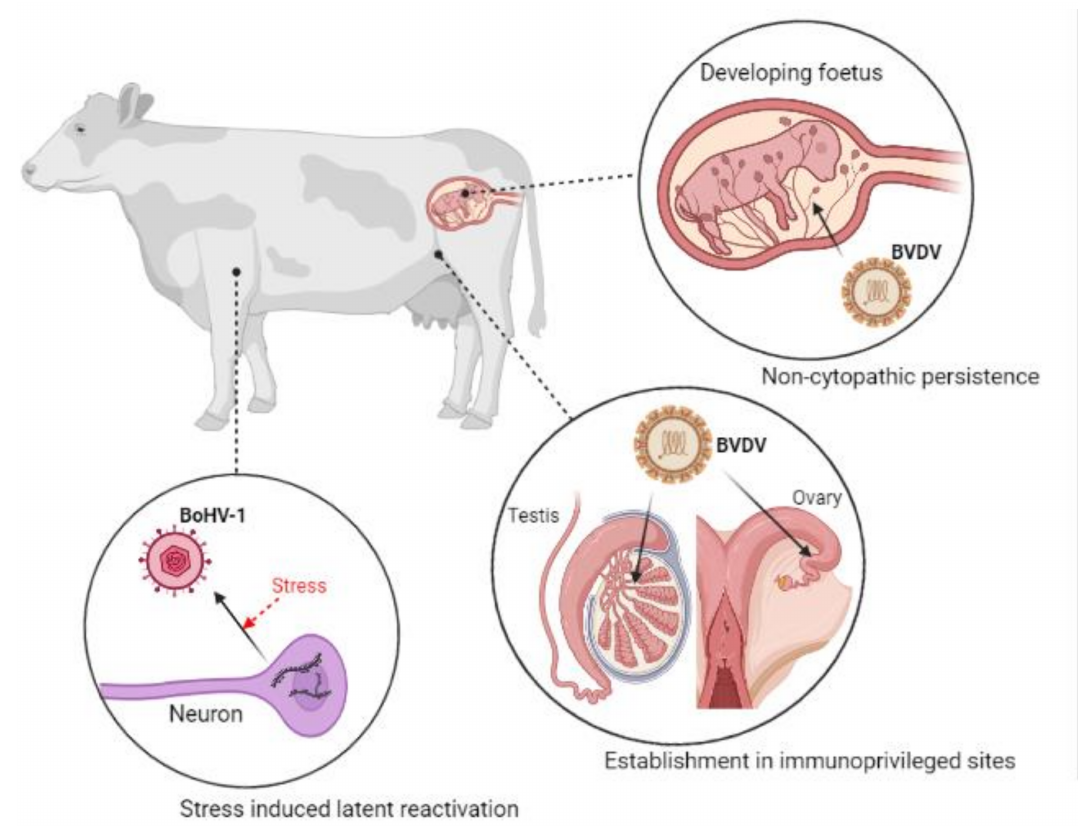
Figure 4. Viral reactivation from latency and establishment in sites of immune tolerance by BoHV-1 and BVDV, respectively. BoHV-1 is commonly a lifelong infection, arising in times of stress. BVDV maintains persistent infections within herds due to non-cytopathic spread from cow to foetus. (Created in BioRender.com, accessed on 24 March